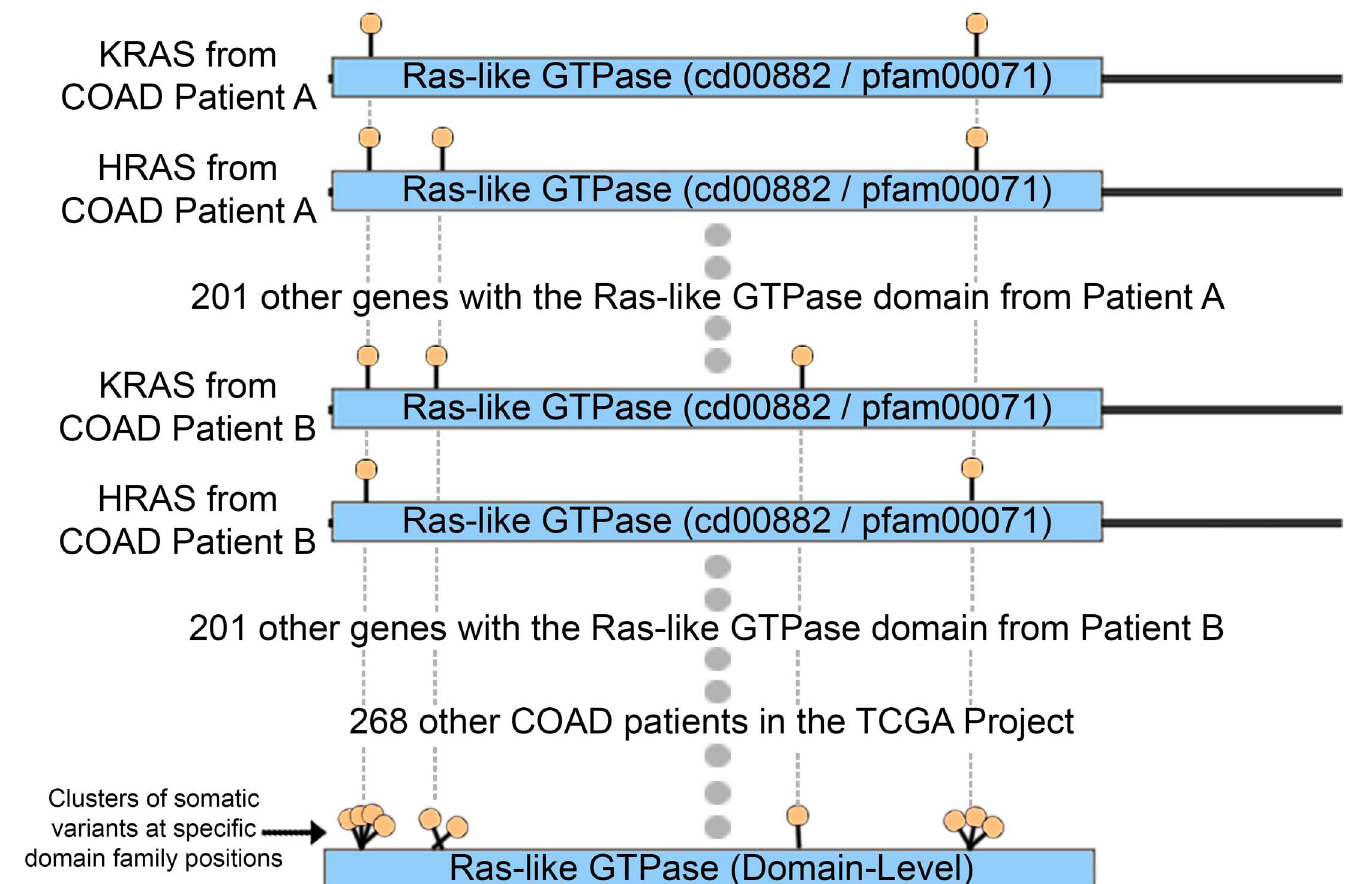
Fig 1. Depiction of the process of mapping variants to domain positions to find oncodomain